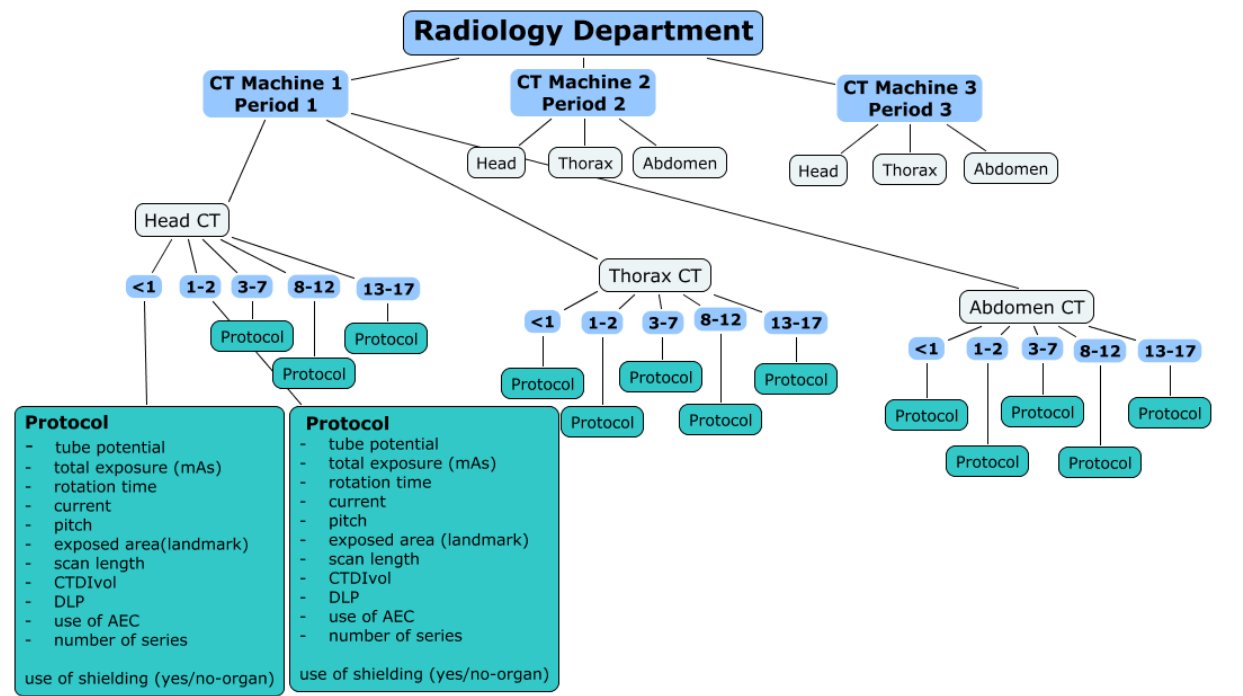
Figure 2. Structure of the questionnaire.